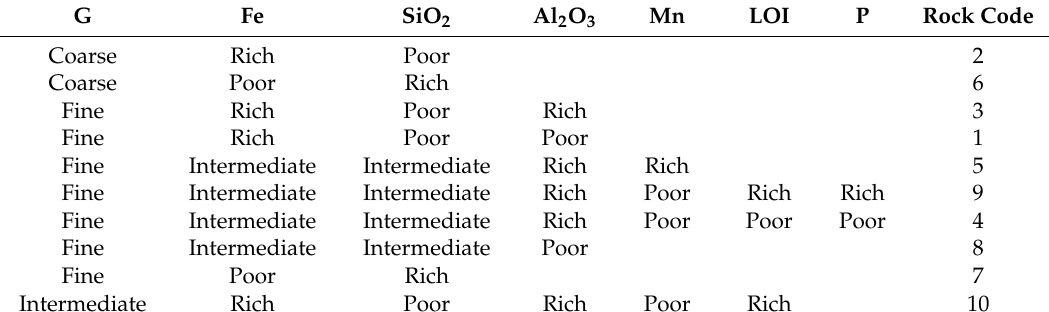
Table 1. Associations between rock types and quantitative variables (for each variable, “poor” and “fine” refer to the rock types with the lowest values, and “rich” and “coarse” to the rock types with the highest values) [23].